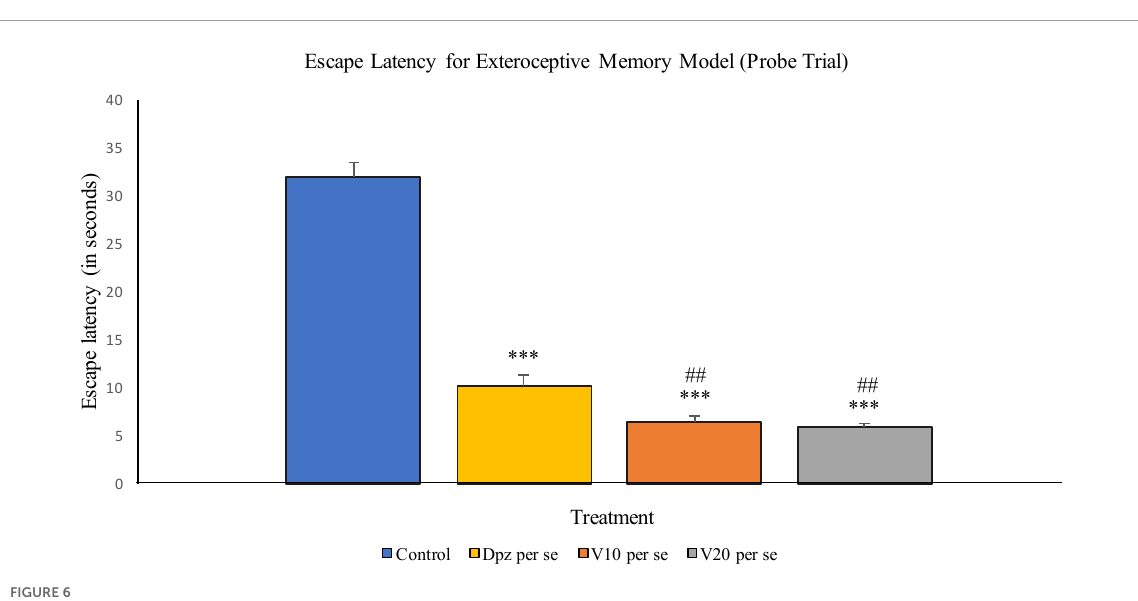
the EL in the probe trial. Both groups receiving the vanillin treatment, V 10 per se (10 mg/kg) and V 20 per se (20 mg/kg), exhibited a significantly ( P < 0.001) lesser EL than the control